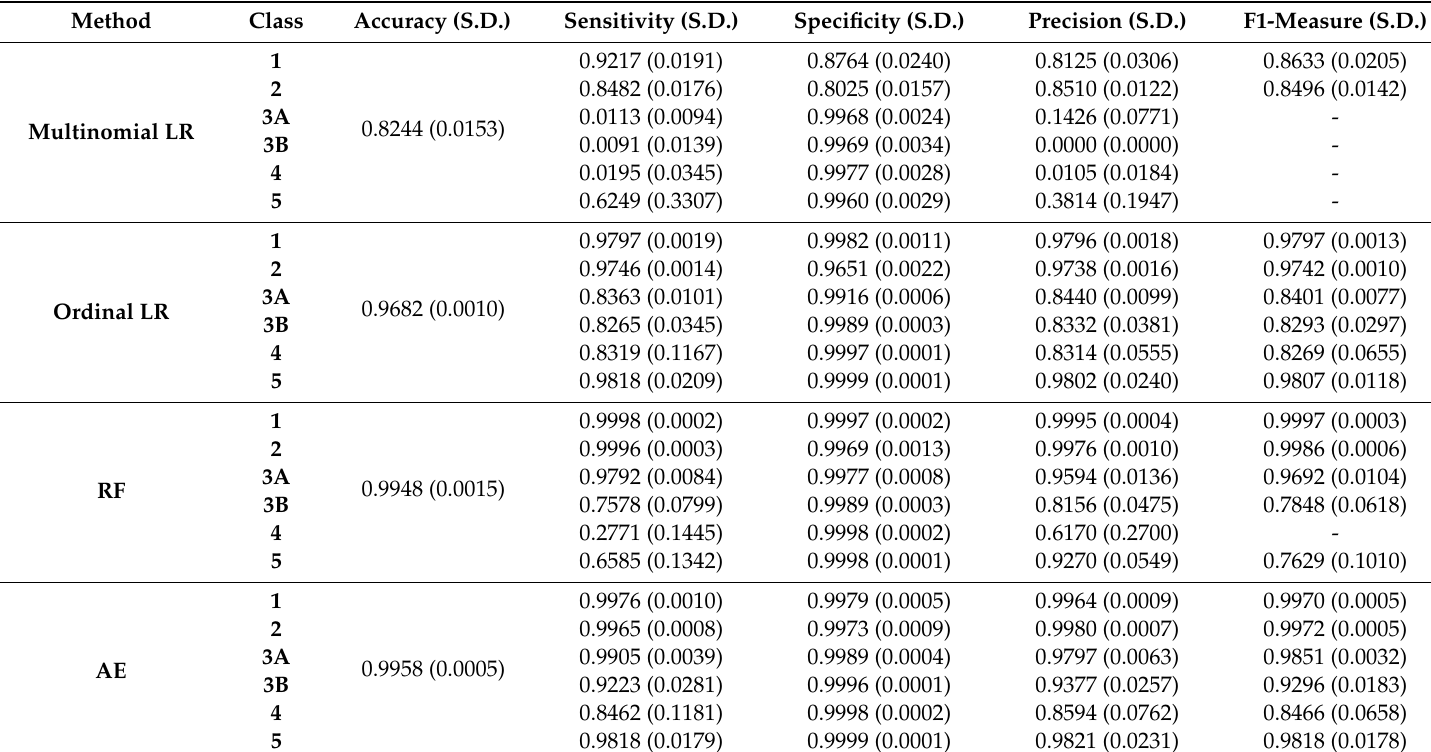
Table 4. Classification performance table (average and standard deviation for 10-fold CV confusion